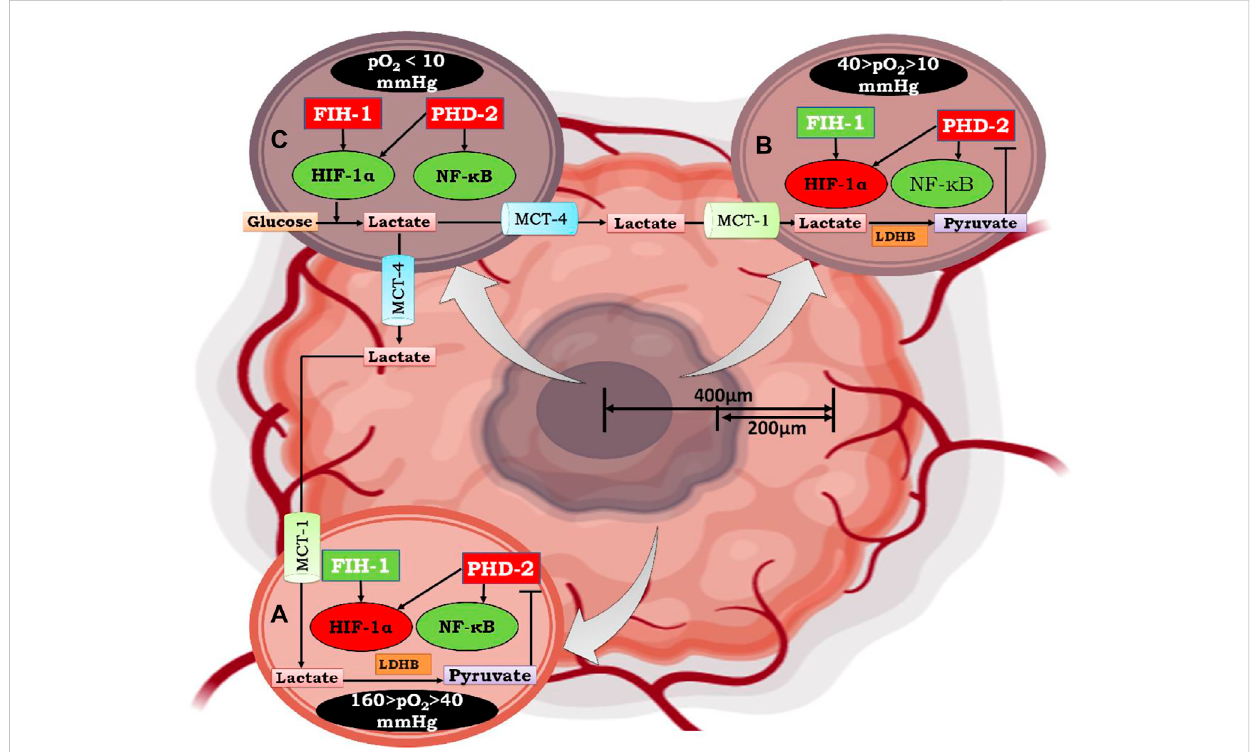
Mechanism of Lactate shuttle mediated activation of NF- κ B under graded oxygen tension. As the tumor size increases to more than 200 μ m, the diffusion of oxygen decreases, which marks the beginning of the condition known as “ intratumoral ” hypoxia. Moving from the periphery to the core (400 μ m), cells are under graded oxygen tension, which ranges from 160 mmHg to less than 10 mmHg. Based on this, cells can be divided into three zones.InFigureA.representsacellthatliesinthenon-hypoxiczone(160 > pO 2 > 40 mmHg),B.representsacellthatliesintheintermittenthypoxic zone (40 > pO 2 > 10 mmHg), and C. represents a cell that lies in a severely hypoxic zone (pO 2 < 10 mmHg). In a non-hypoxic cancer cell (A) and intermittent hypoxic cancer cell (B), ef fl uxed lactate enters through MCT-1 and is converted to pyruvate by the enzyme lactate dehydrogenase B. The conversion of lactate to pyruvate causes competitive inhibition of 2-oxoglutarate by pyruvate, which is the substrate for enzyme Prolylhydroxylase- 2(PHD-2). Henceforth, PHD-2 fails to degrade IKK β , resulting in the activation of NF- κ B, which further regulates the downstream mechanism of cancer cell survival, growth, and proliferation. In contrast, HIF-1 α , which assumes stability due to inactivation of PHD-2, does not undergo transcriptional activation because ofhydroxylationatN803 ofitsC-TADbyfactorinhibitingHIF-1 α (FIH-1). Although FIH-1,similarto PHD-2, belongs to thegroupof 2- oxoglutarate dependent dioxygenases, has a Km value of 55-60 μ M for 2-oxoglutarate, which is double that of PHD-2, whose Km value for 2- oxoglutarateis25 μ M.Moreover, FIH-1remained active upto an oxygen tensionof10 mmHg. Therefore,FIH-1 effectivelyinhibits HIF-1 α transcriptional activity in non-hypoxic and intermittent hypoxic zones. Henceforth, it can be postulated that in these zones cell survival and proliferation is under in fl uenceofNF- κ B.Inhypoxiccancercells,lactateaccumulates duetoexcessiveglycolysis,whichresultsinanincreaseinintracellularacidity.Inorderto cope with intracellular acidity, hypoxic cancer cells ef fl ux lactate into the extracellular environment through monocarboxylate transporter-4 (MCT-4). Moreover,inhypoxiccancercells, bothPHD-2 andFIH-1wereinactiveduetoverylowoxygen tension(pO 2 < 10 mmHg). Thus,HIF-1 α isbothstable and transcriptionally active along with NF- κ B. Therefore, cell survival and proliferation are in fl uenced by both HIF-1 α and the in fl ammatory partner NF- κ